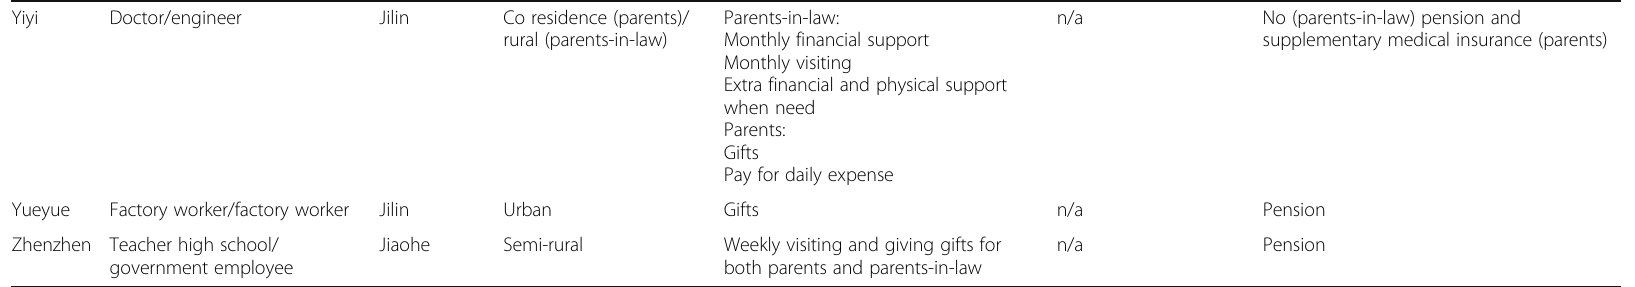
Table 1 Individual circumstances and care for elders